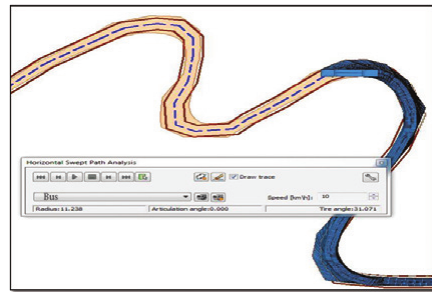
Fig. 4. Simultaneous horizontal driving analysis for bus